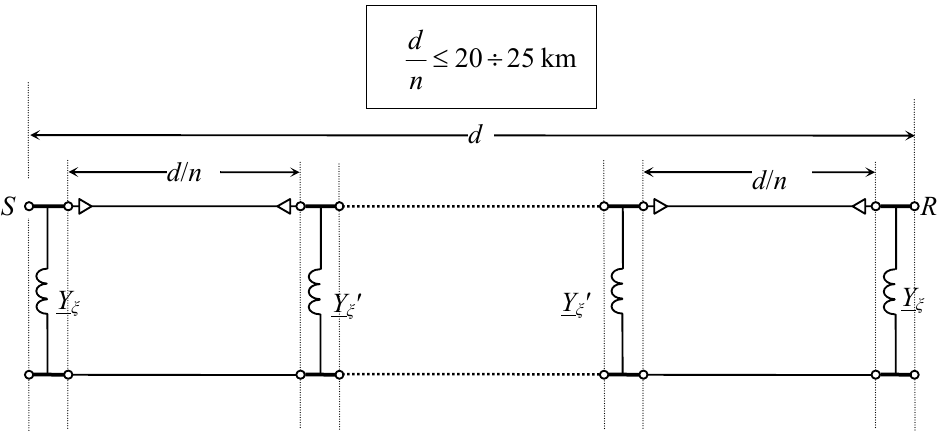
Figure 2. Lumped shunt compensation at the ends and at intermediate locations.